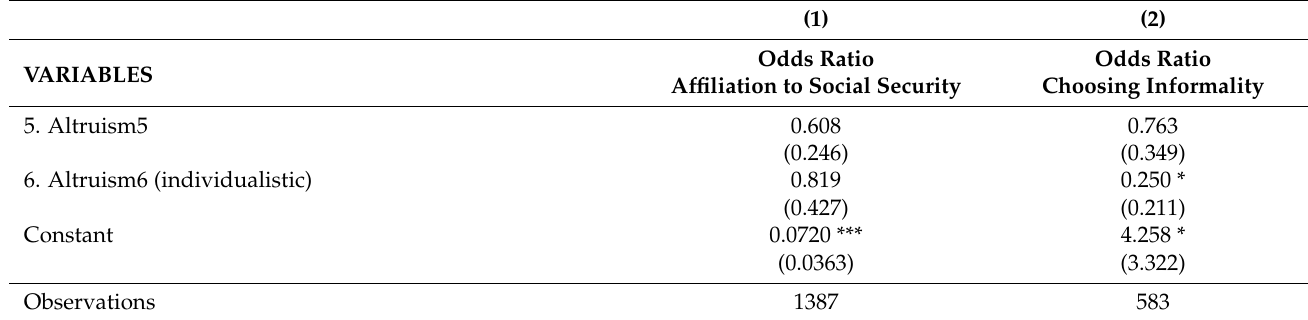
Model 2 : The second model in the third column of the table above (Table 2)